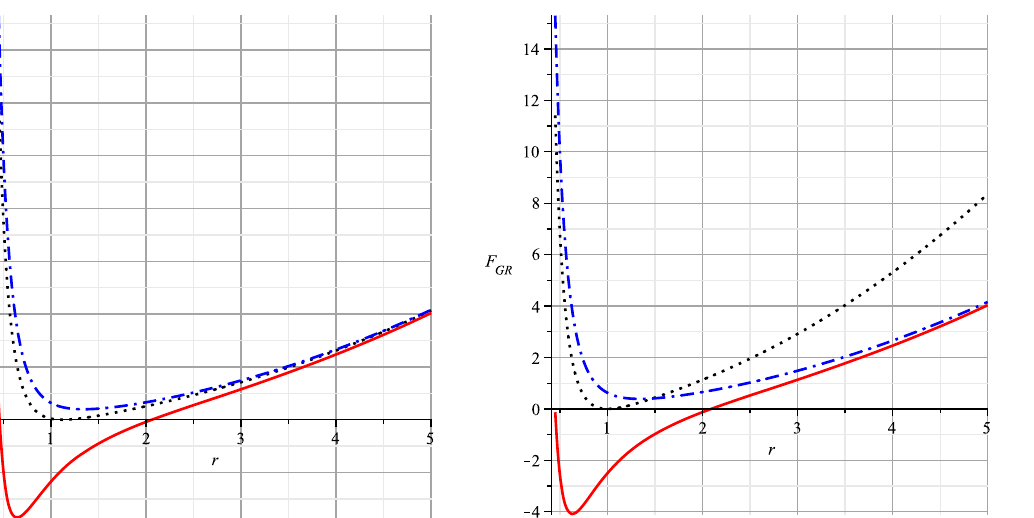
Fig. 1 Plot of the metric function F ( r ) in the GR-limit (2.4), where the left panel corresponds to the electric solution for (cid:3) = − 1 and √ / | (cid:12) | = 2 / Q 3, while the right panel is the dyonic situation with the e 3 same values of (cid:3) and Q e / | (cid:12) 3 | , together with Q m / | (cid:12) 3 | = 0 . 1. For both